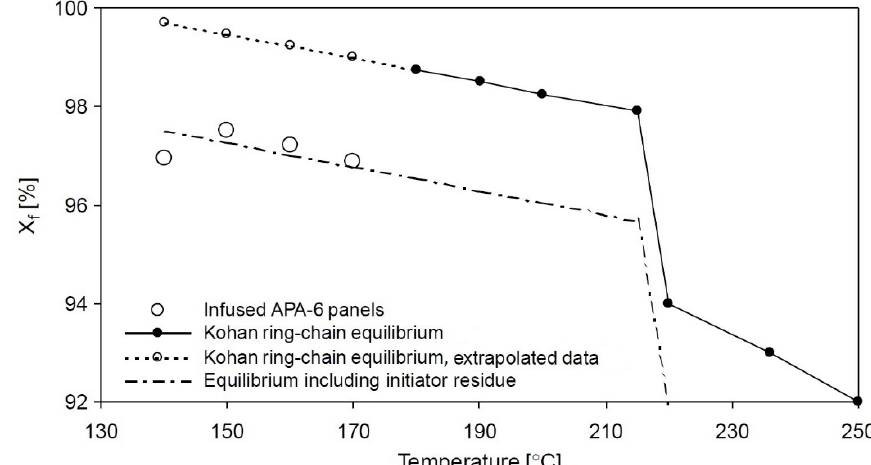
Figure 4. Final degree of conversion (t = 30 min) of the infused polymer panels for various polymer- ization temperatures and Kohan ring–chain equilibrium data. Reprinted from Reference [10], under open-access license.